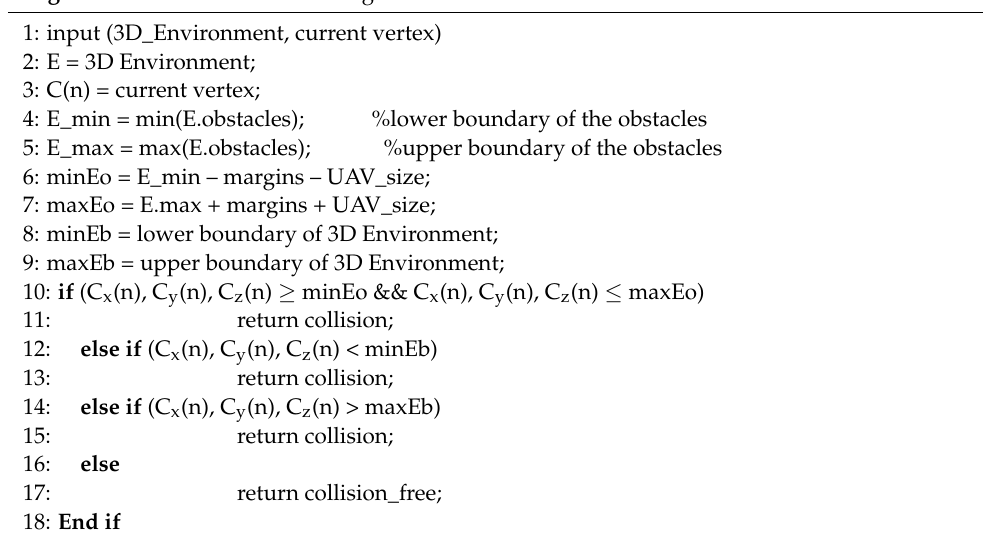
Algorithm 2 Collision detection